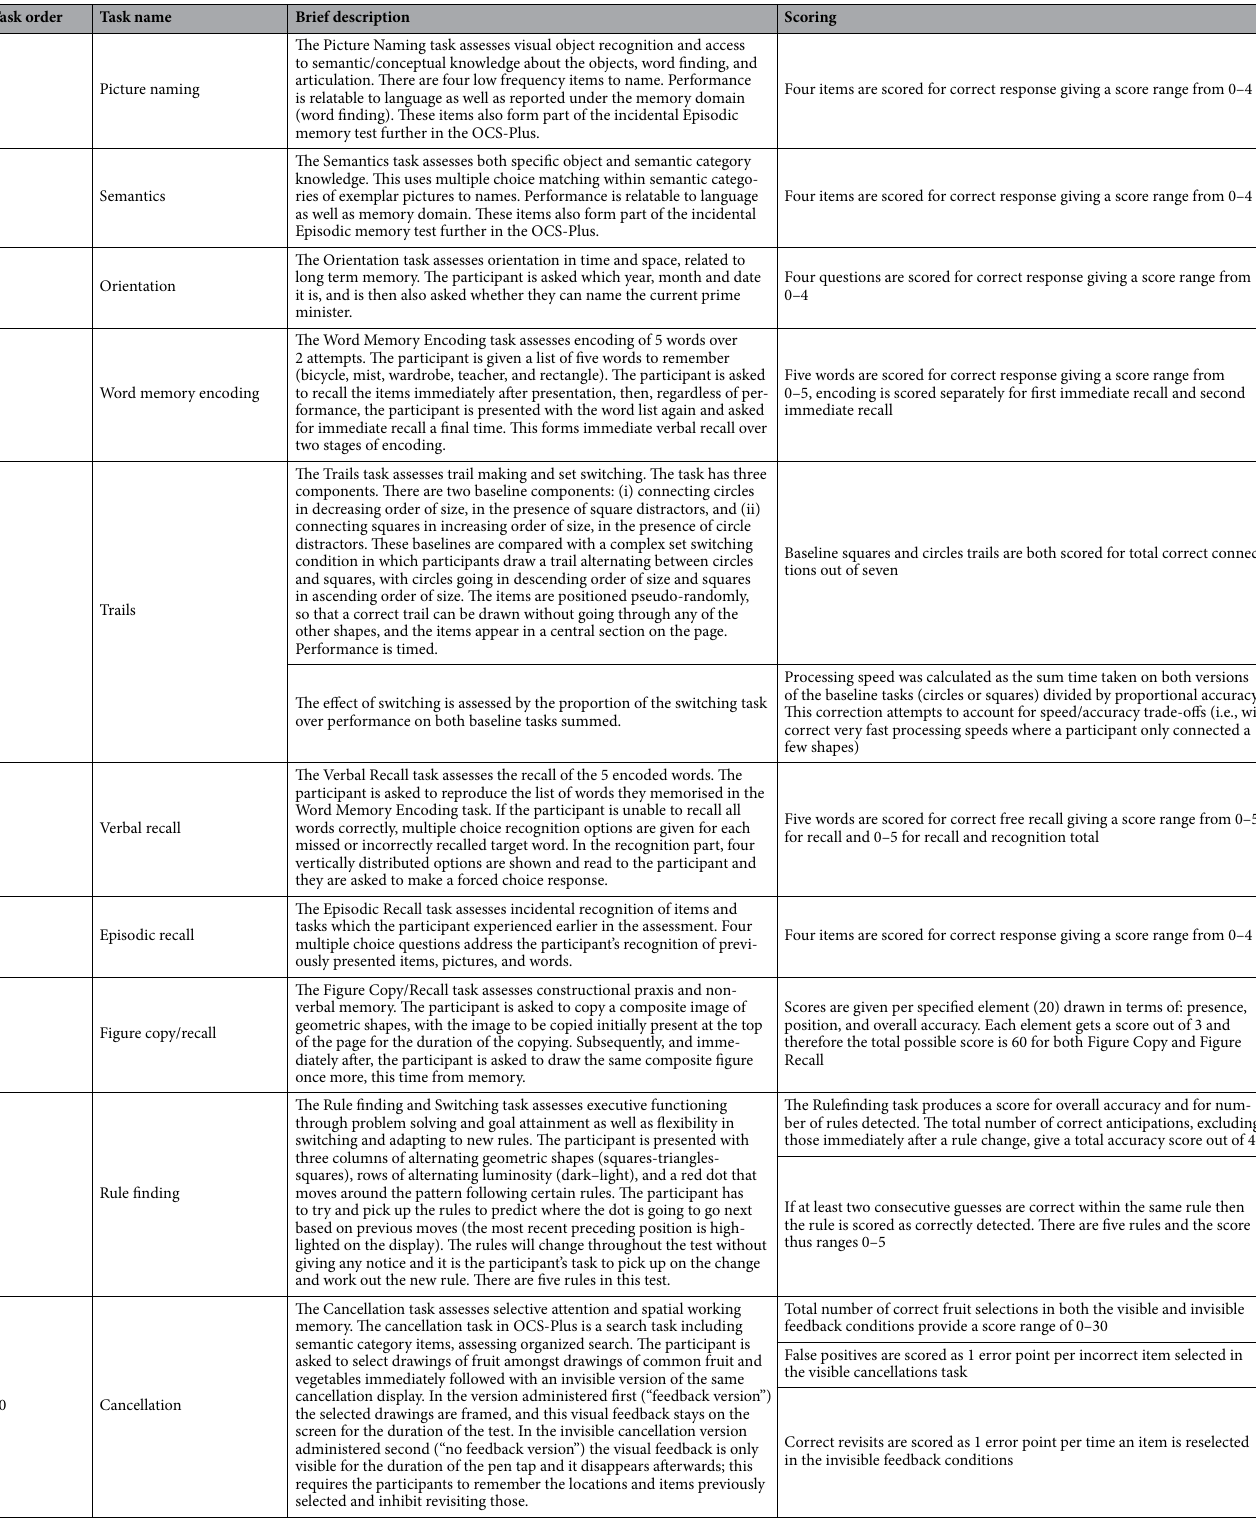
Table 2. Brief subtask descriptions and order of administration within OCS-Plus. Oxford Cognitive Screen- Plus (OCS-Plus). Images of each subtask are presented in Supplementary Material. A video demonstration of all tasks is available on Open Science Framework 24